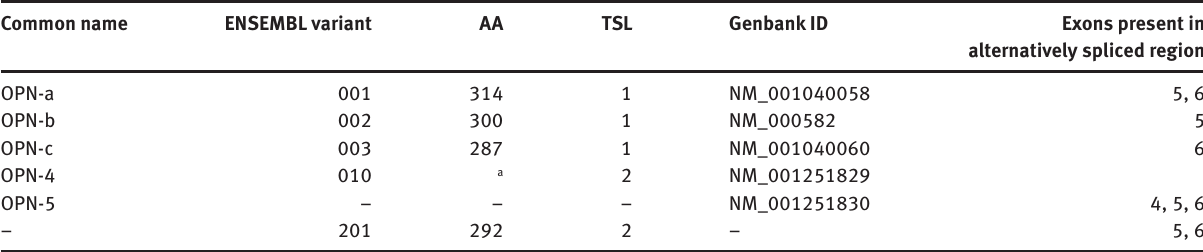
Table 2: Osteopontin variants encoded by the SPP-1